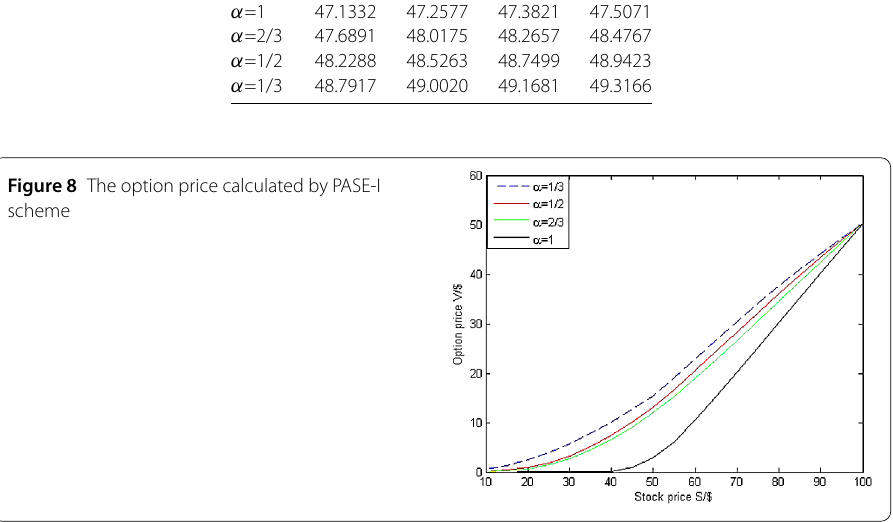
Table 5 Comparison of numerical solutions of PASE-I scheme Month